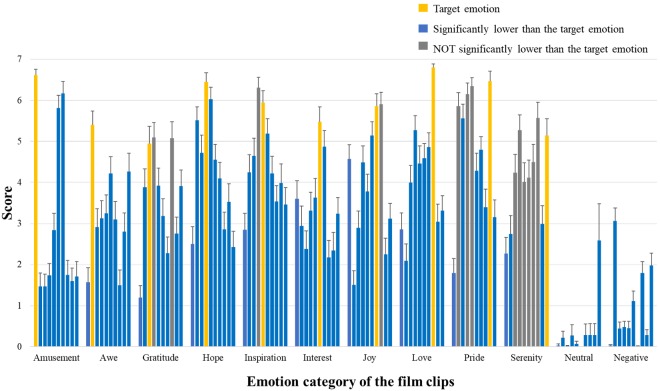
Basic information of emotion ratings. Participants’ ratings on the 10 positive emotional experience items. For each emotion category of film clips, the 10 bars indicate the mean ratings of these clips on amusement, awe, gratitude, hope, inspiration, interest, joy, love, pride, and serenity (from left to right). The bars in yellow show the ratings on the corresponding target emotion; The bars in blue mean their ratings significantly lower than those of the target emotion (post hoc paired t-tests p < 0.05, FDR corrected); The bars in gray indicate ratings NOT significantly different from those of the target emotion (p > 0.05, FDR corrected).